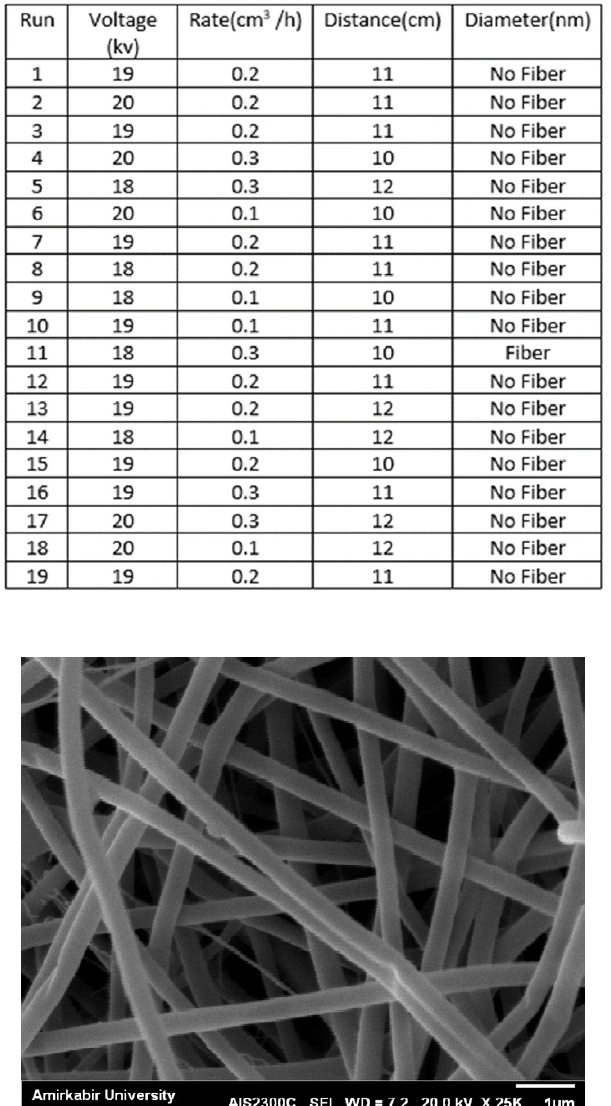
Table.1. Design of experiment for preparing the nanofibers